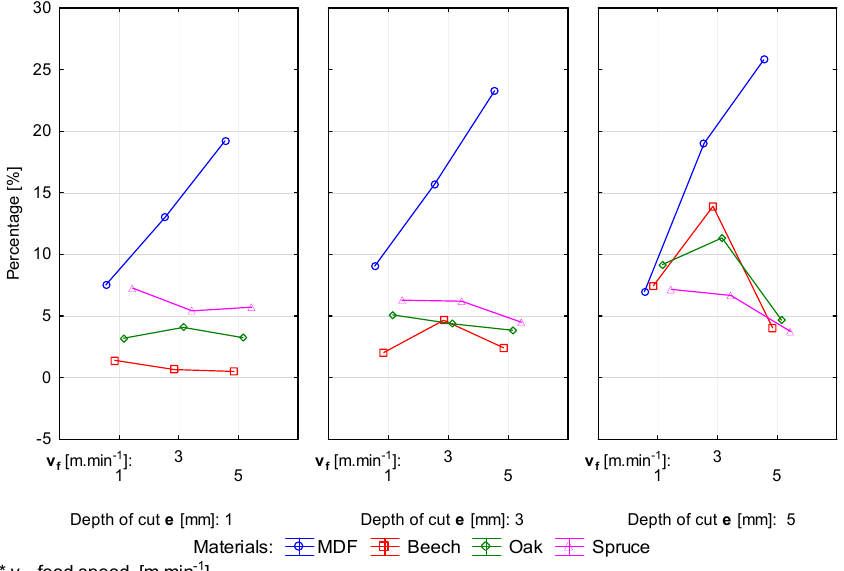
Figure 6. Grain size grade 125 μ m.